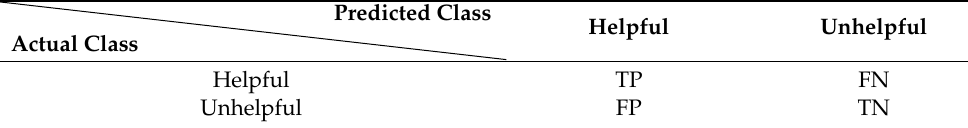
Table 4. Confusion matrix example for evaluating the performance of helpfulness classification. Actual